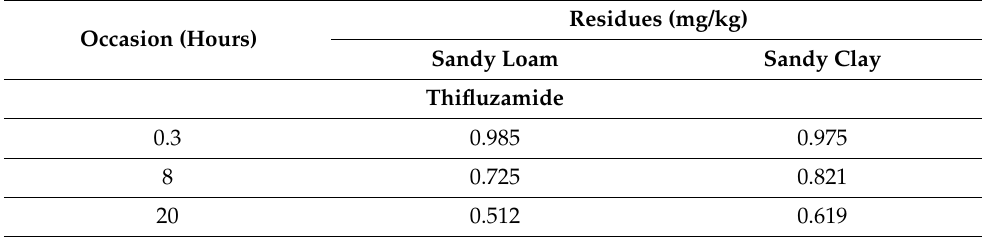
Table 6. Data on dissipation for photocatalytic fungicide remediation in soil under